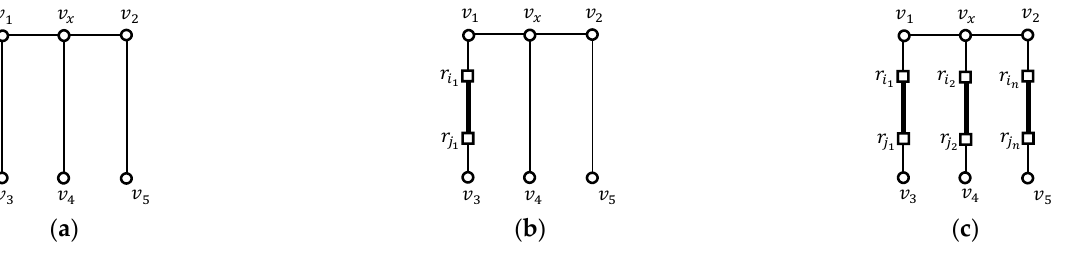
Figure 9. Simple heuristic S ε r